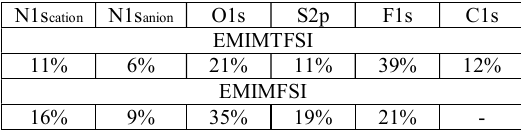
Table 1. Estimated atomic percentage (%) of on the elements present in [EMIM + -TFSI - ] and [EMIM + -FSI - ] ionic liquids.